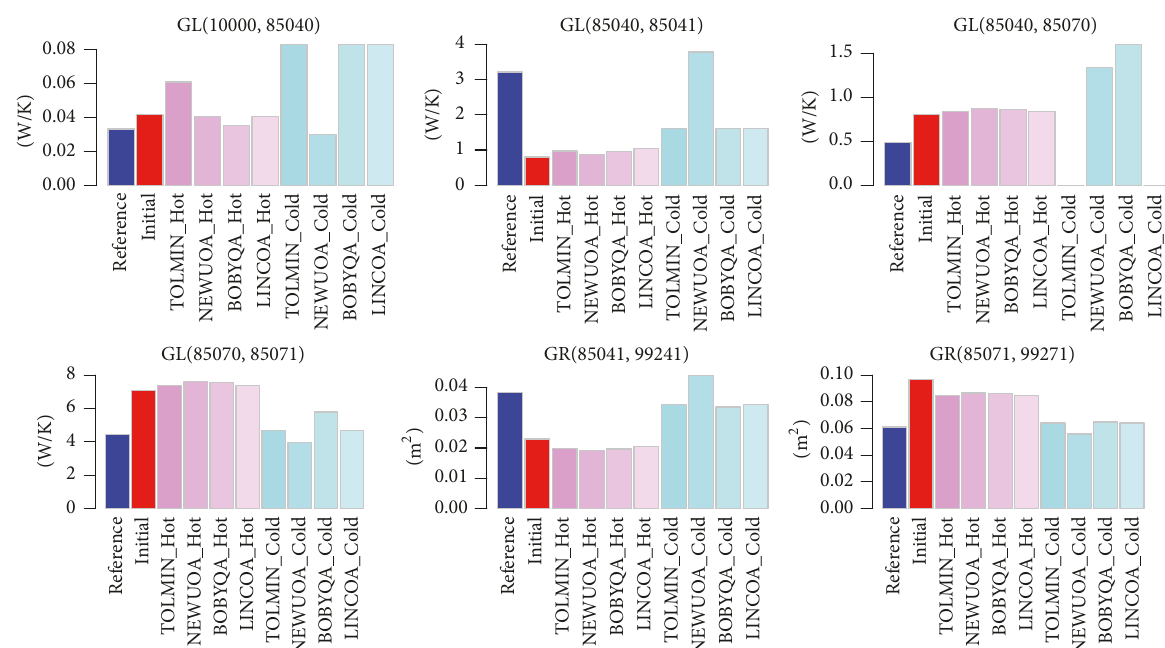
Figure 4: Steady-state, classical methods. Variable values obtained from correlations.